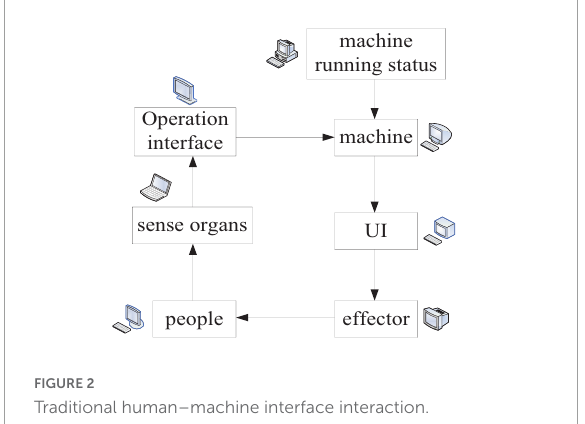
FIGURE2 Traditional human–machine interface interaction.